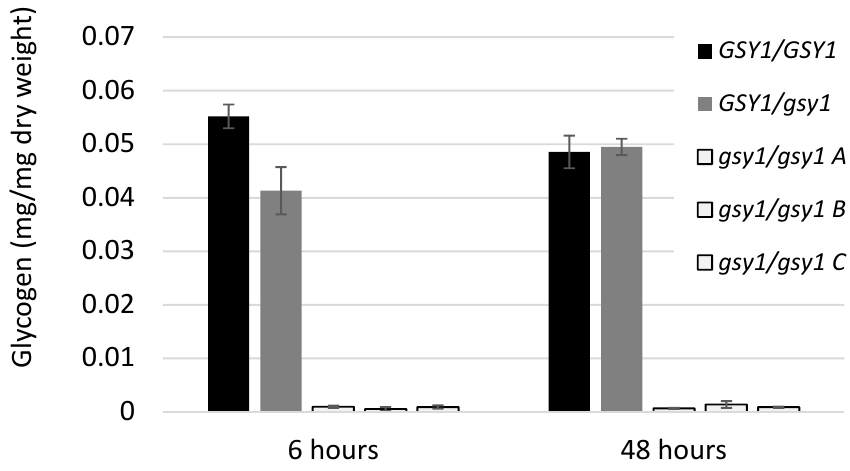
Figure 2. Glycogen content of WT, heterozygous and homozygous glycogen synthase mutants in exponential (6 h) and stationary (48 h) phase of growth. Glycogen content of three independent gsy1/gsy1 isolates is shown. The difference in glycogen content between WT and gsy1/gsy1 mutant is significant at the 5% level.